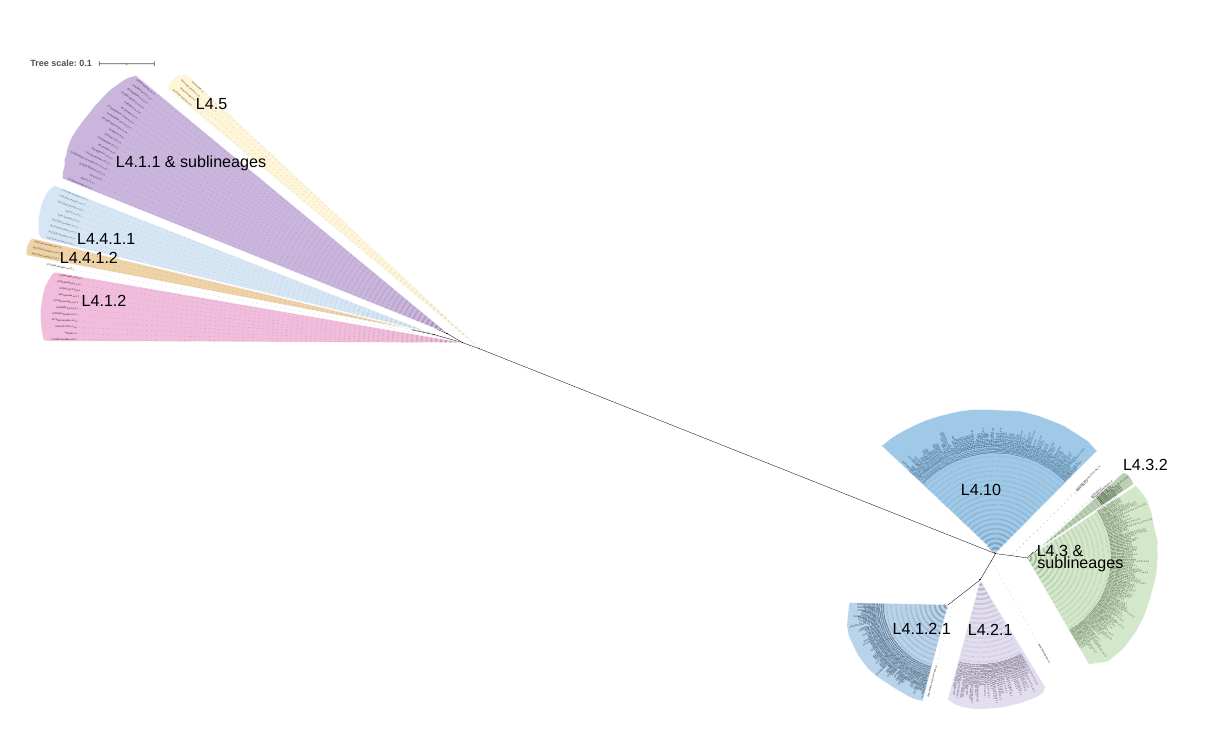
Figure 2. Sub-lineage clustering using 16 non-synonymous SNPs in 13 genes related to DNA damage